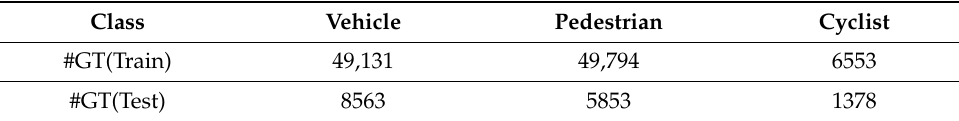
Table 2. Description of SCOD.